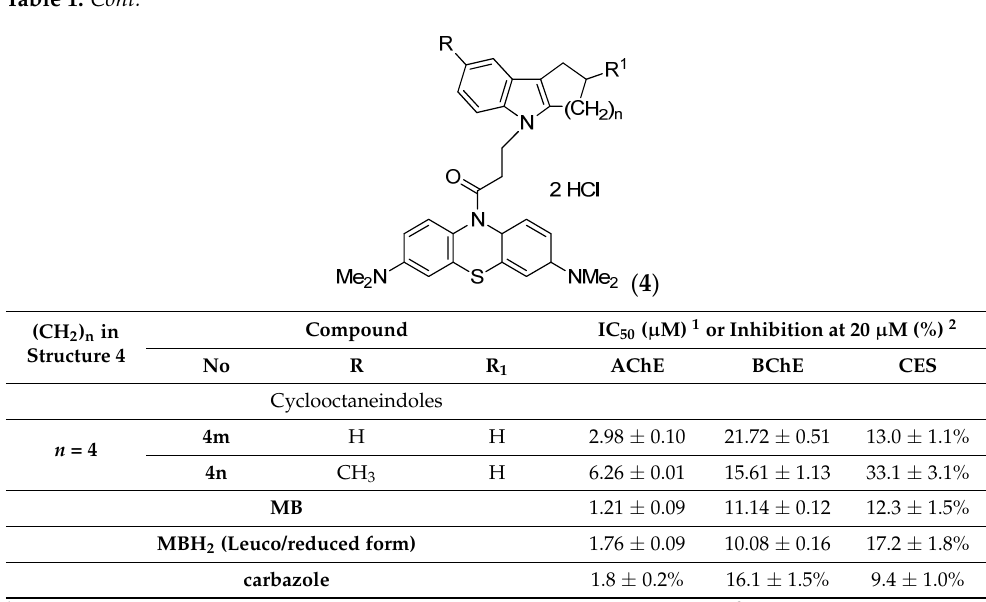
Table 1. Inhibitory activity of MB-cycloalkaneindoles conjugates 4 against AChE, BChE, and CES. Table 1. Cont.